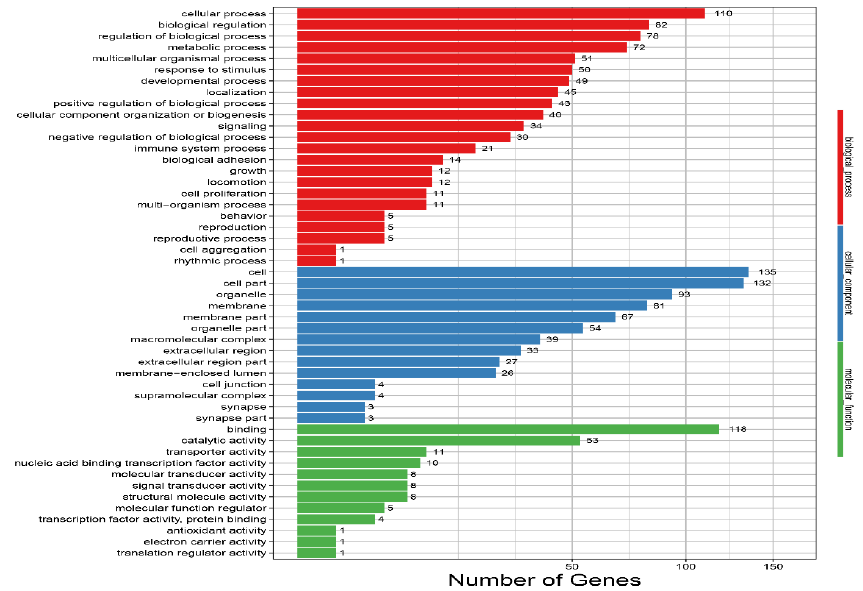
Figure 5. Enriched gene ontology (GO) terms for the BG and the LG. The vertical axis indicates GO terms, and the horizontal axis represents the number of DEGs. The numbers of enriched genes in each GO term are shown in the biological process (red color), cellular component (blue color), and molecular function (green color) areas. BG, barren environment group; LG, environment enriched with a litter materials group.